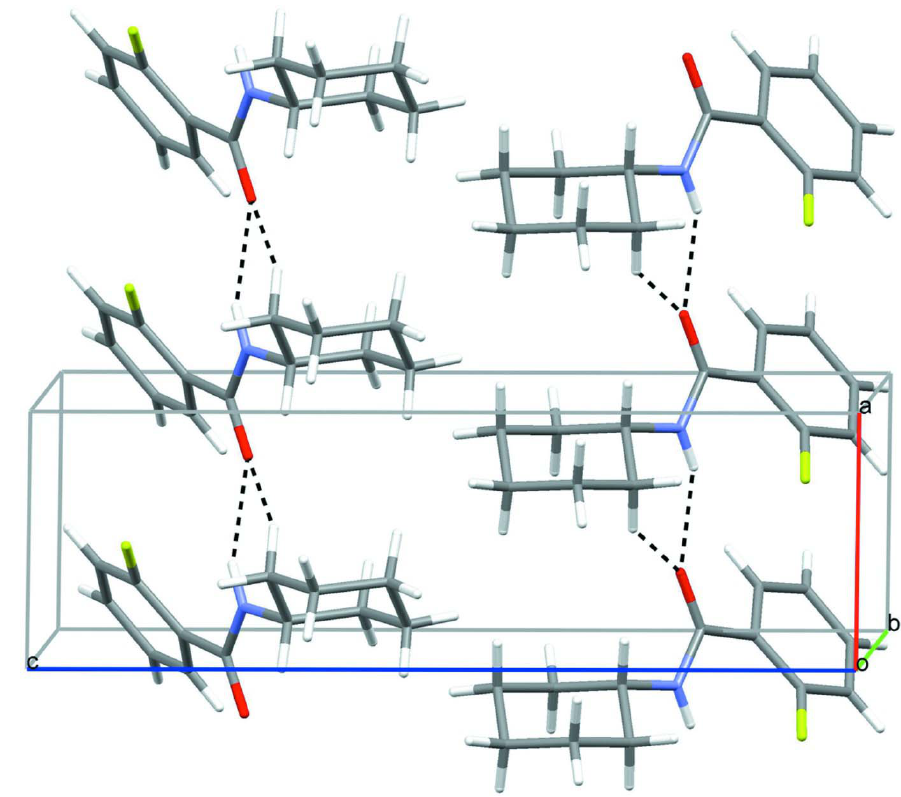
Figure 2 Transverse chains formed along a by N—H···O hydrogen